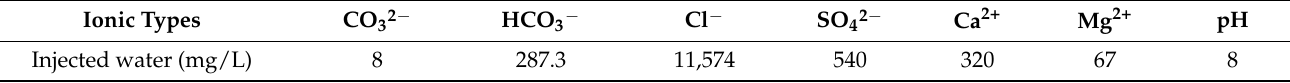
Table 1. Ion components of Mahu injection